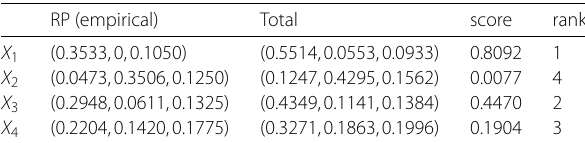
Table 3 The results of personnel selection problem